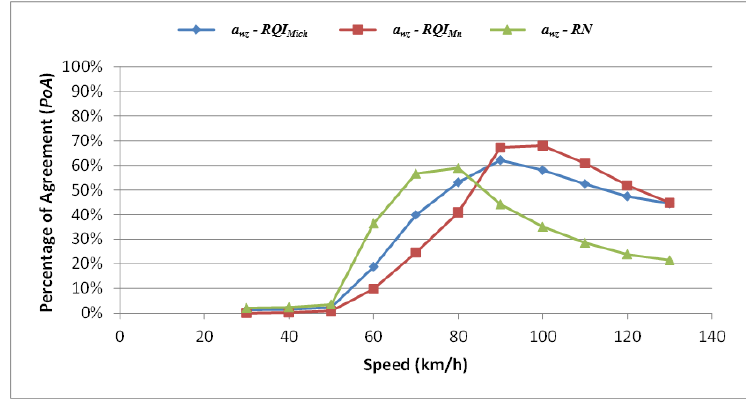
Figure 7. Percentage of agreement ( PoA ) between RN , RQI Mich and RQI Mn with ISO 2631 a wz .